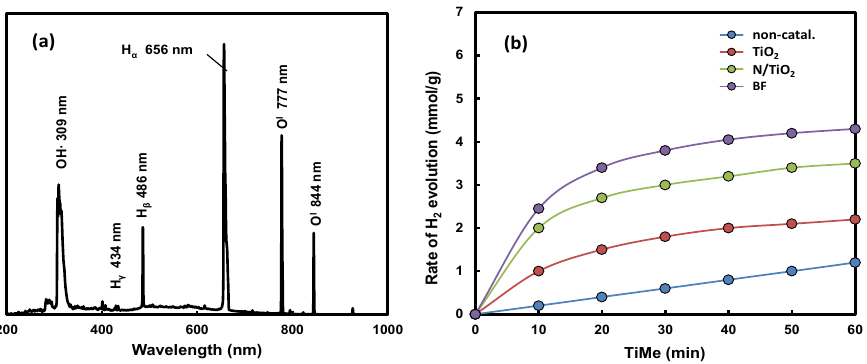
Figure 6. ( a ) OES spectrum of DW, and ( b ) HER under conditions without and with various catalysts.